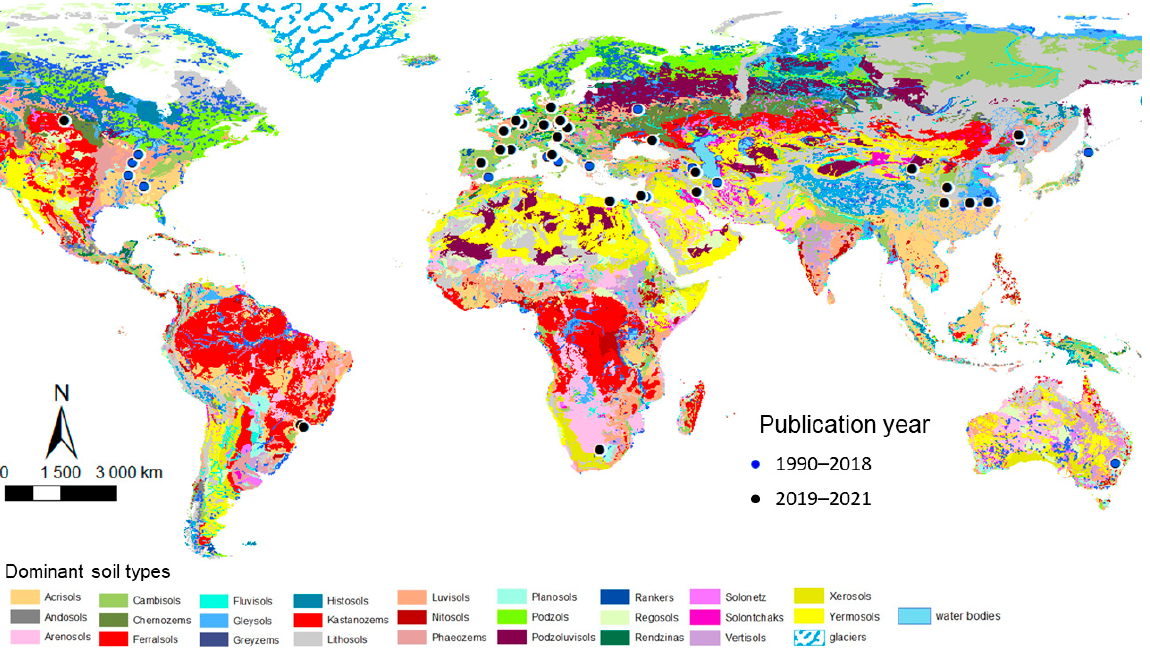
Figure 2. World map of satellite-derived SOC studies and the dominant soil types of the FAO- UNESCO Digital Soil Map of the World at 1:5.000.000 scale [69]. Time spans are split according to the first year of Sentinel-2 based SOC studies, i.e., 2018.